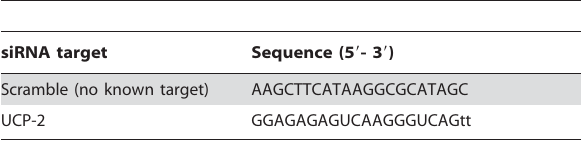
Table 2. Sequence of siRNA towards UCP-2 and scrambled